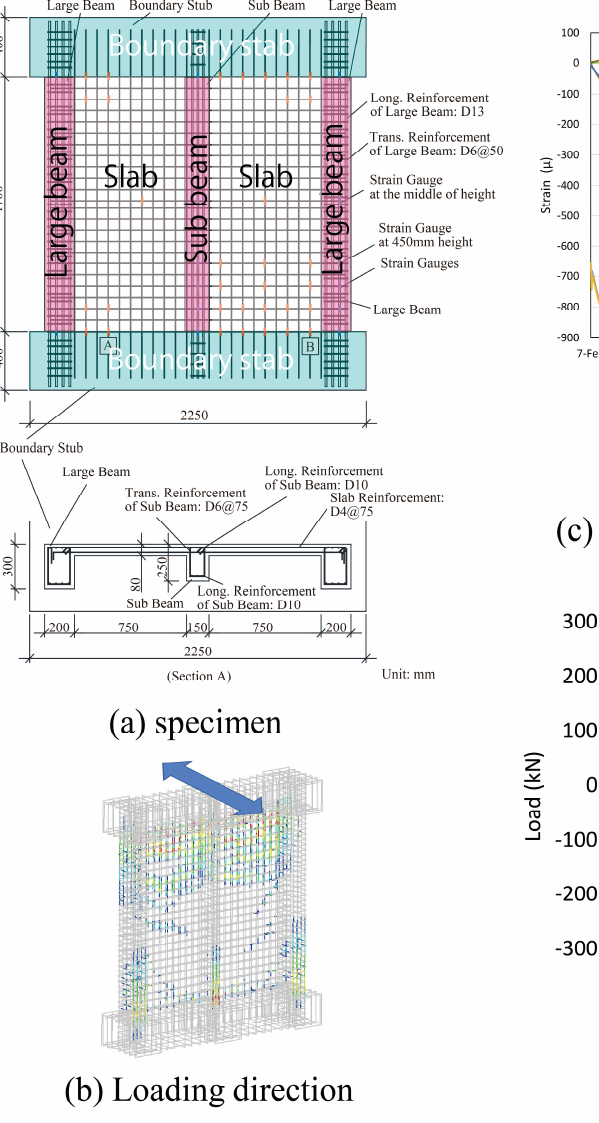
Figure 5. Experimental results of RC slabs with/without drying shrinkage: a) specimen, b) loading condition, c) shrinkage and temperature histories of dummy specimens, d) load-deformation relationship. After [37]. Note: (a) DXX means the deformed bar with the nominal diameter of XX mm. (c) the legends whose final character is “T” represents the temperature (right axis). Shrinkage of the specimen at the central region was measured by the embedded strain gauge. All the data were obtained by the dummy specimens whose sectional size was the same as that of corresponding member shown in (a) and the length was 300 mm. (d) Load represents the horizontal load to push/pull the top stab to bend the slab with beams. The same setup shown in Fig. 4(b) was